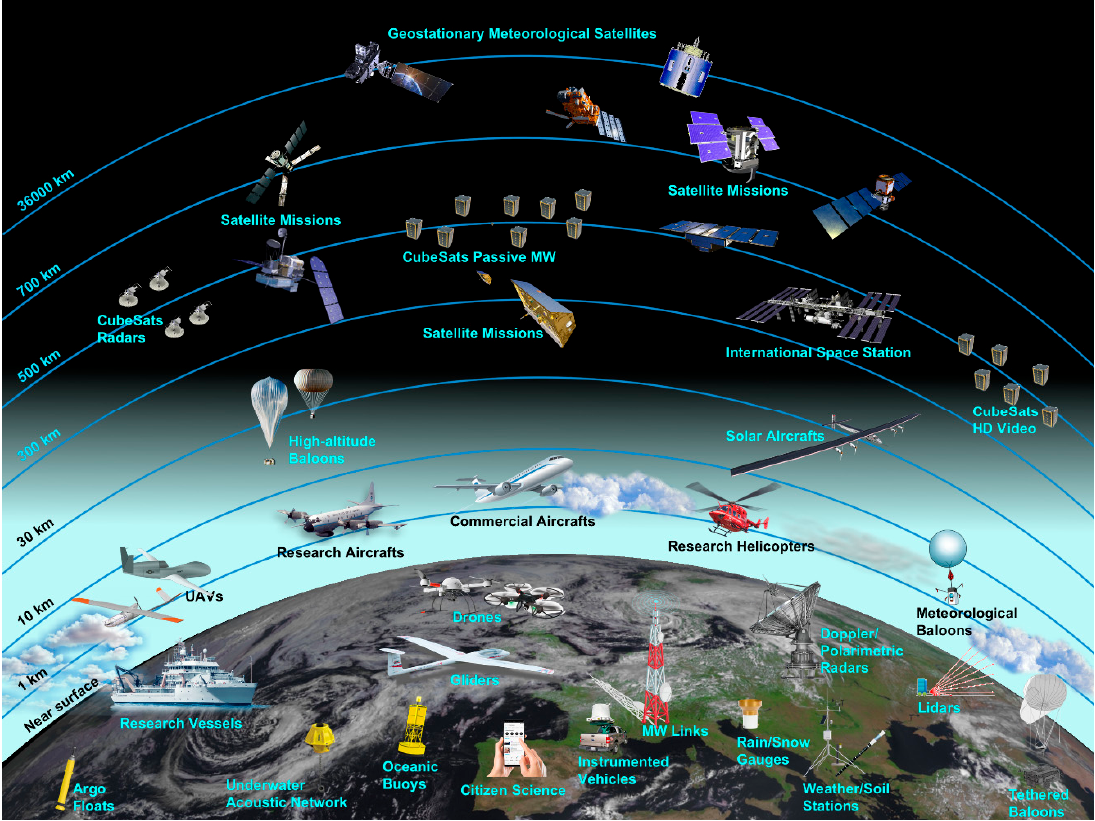
Figure 4. The global observing system of the water cycle.